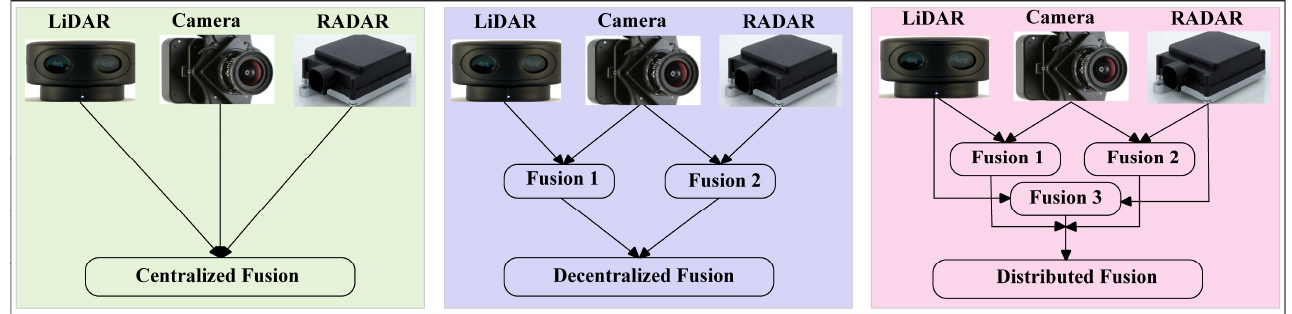
Figure 5. Centralized, decentralized, and distributed types of fusion technologies used for autonomous systems design. Distributed fusion technology has been used in the proposed system.